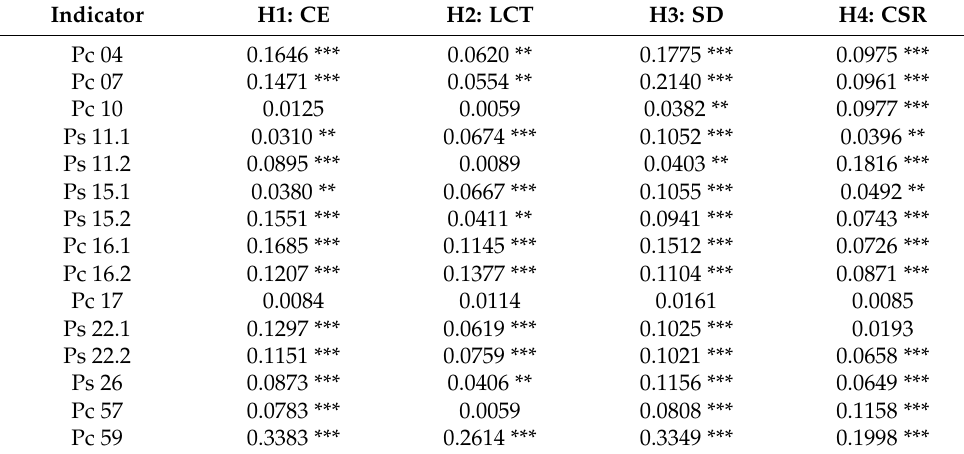
Table 6. Regression models related to H1, H2, H3 and